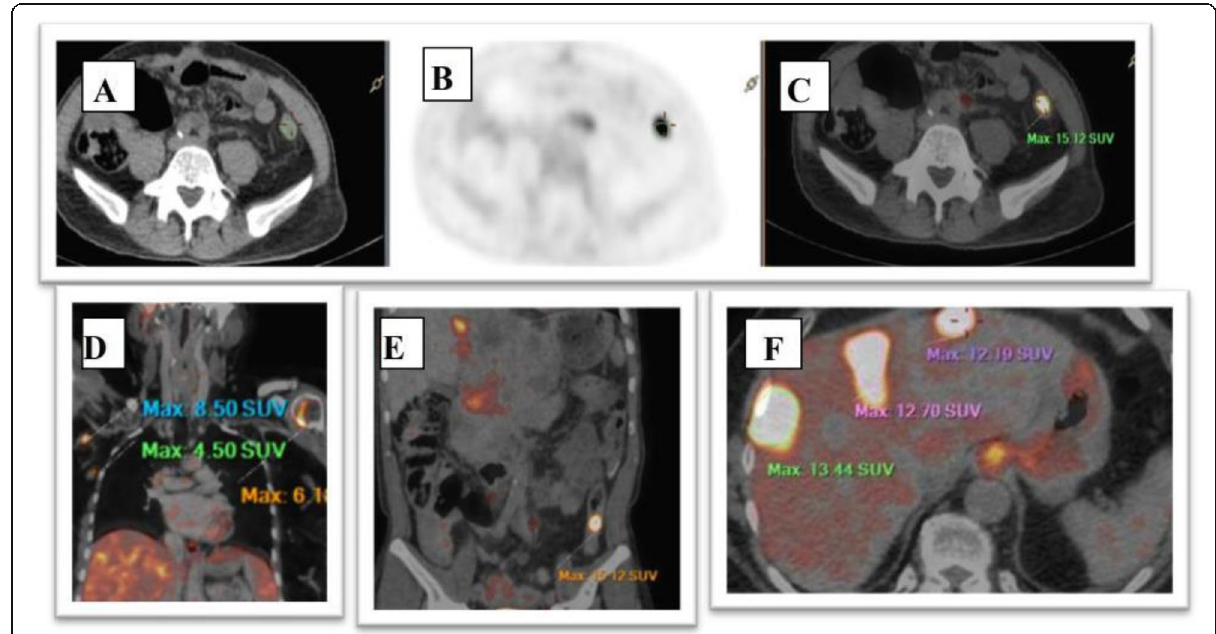
Fig. 2 A 75-year-old male patient with a history of colon cancer treated by surgical resection. He was referred for routine follow-up by PET/CT. a Axial CT, b axial PET, c , e axial PET/CT, d , e coronal PET/CT showing the following: focal mural increased FDG uptake is noted at the distal aspect of the descending colon, just below the surgical anastomotic site achieving 15.12 SUV max proved to be recurrent by endoscopy and